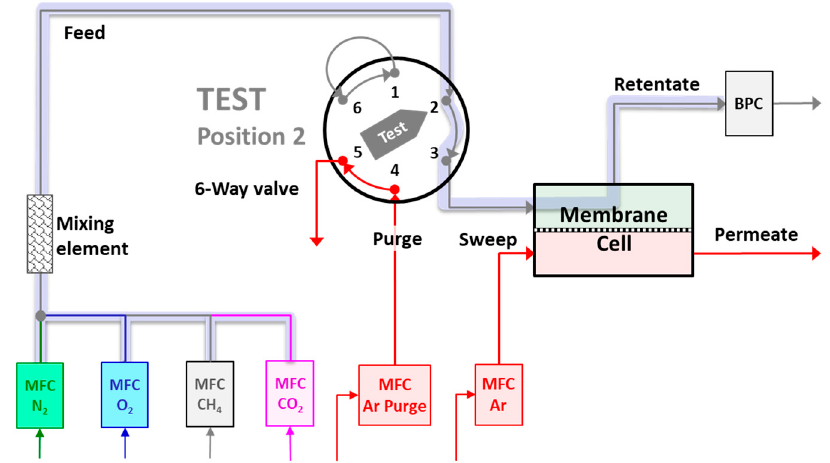
Figure 3. Details of the experimental setup, highlighting with the thick shaded grey line the feed section, which determines the pressure increase rate (adapted from Fraga and Jansen et al. [35]).